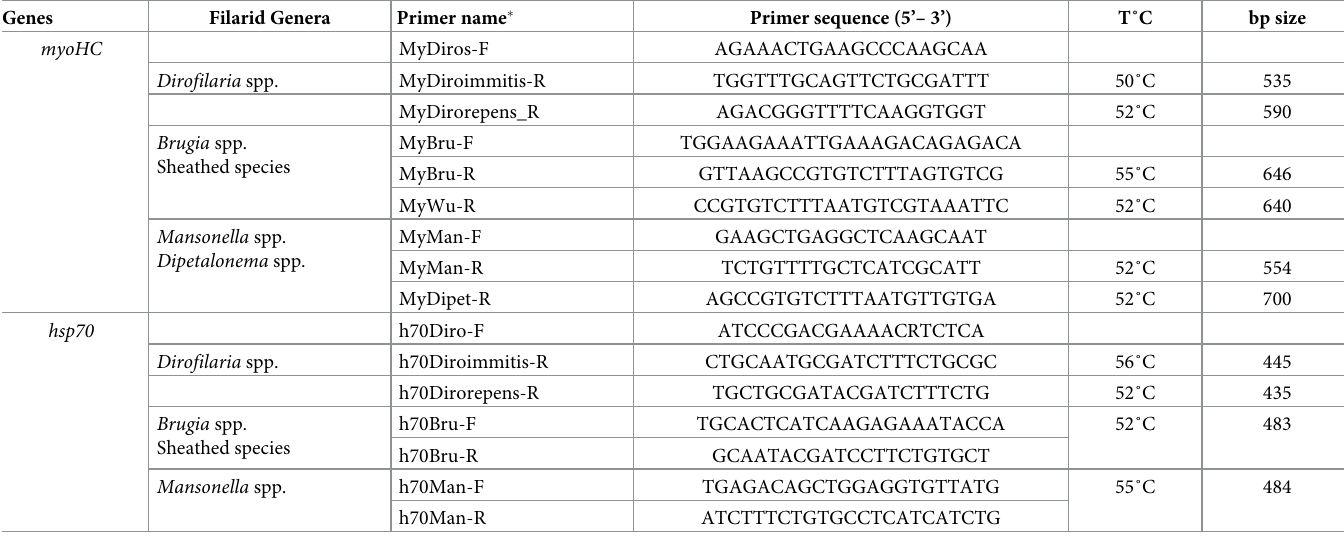
Table 2. Primers designed for amplification of myoHC and hsp70 genes of selected Onchocercidae species. Genes Filarid